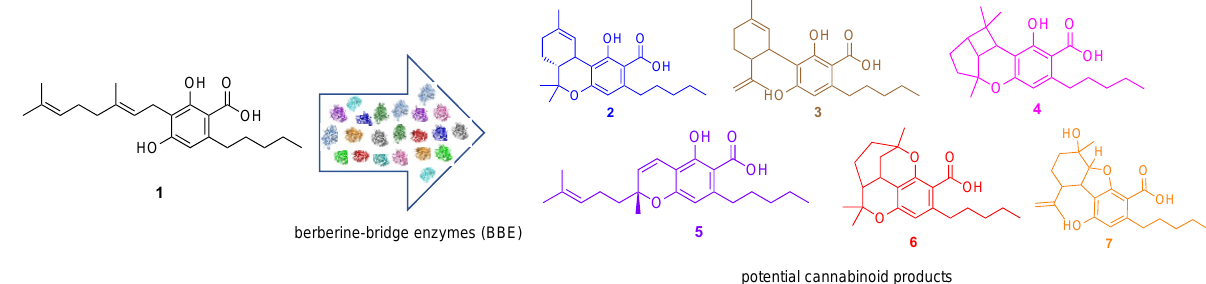
Scheme 2. Schematic of workflow for the screening of orthologs for cannabinoid synthase activity using CBGA (1) as